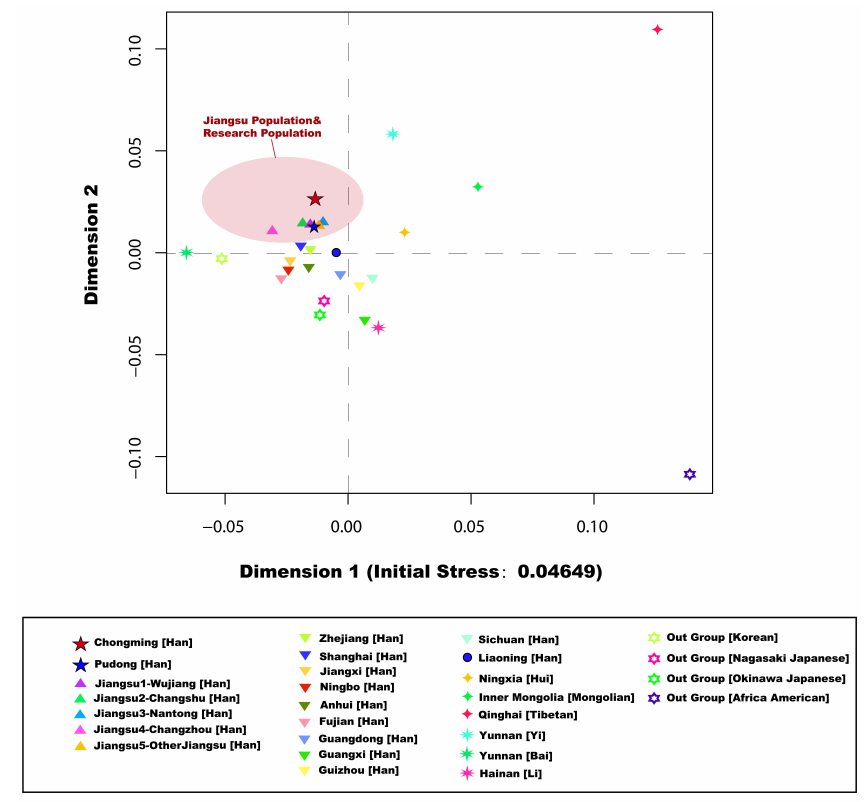
Figure 3. Multidimensional scaling (MDS) plots of 28 populations based on pairwise genetic distances (Rst). Five populations of Han nationality in Jiangsu Province and the studied population are shown in the red